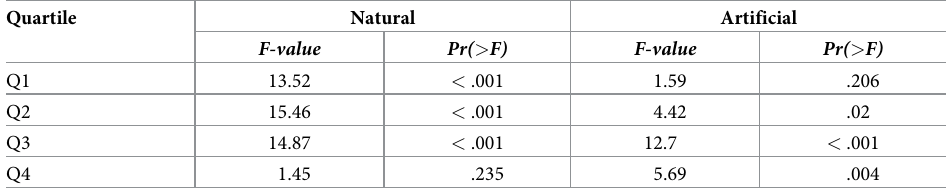
Table 4. F-statistics for anova of models divided by category and